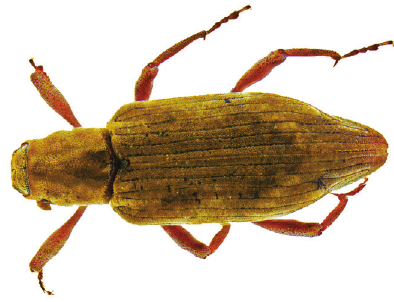
Figure 41. Pseudobagous cf. longulus